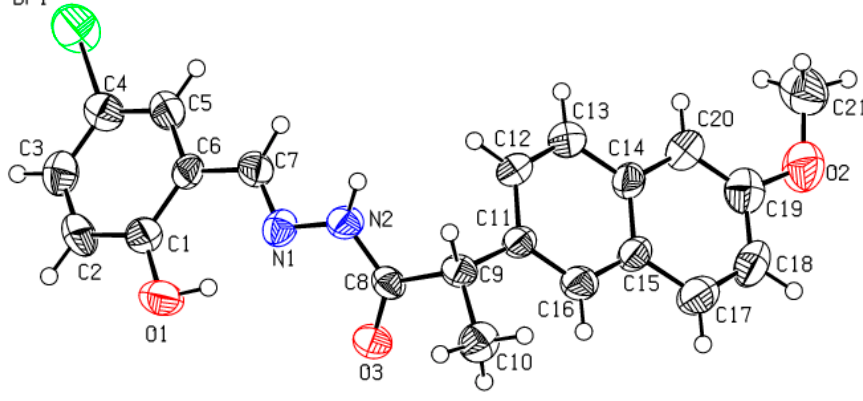
Figure 1. ORTEP diagram of the Schiff base ( 5 ) with thermal ellipsoids drawn at the 50% probability level. The H-atoms are shown as small circles of arbitrary